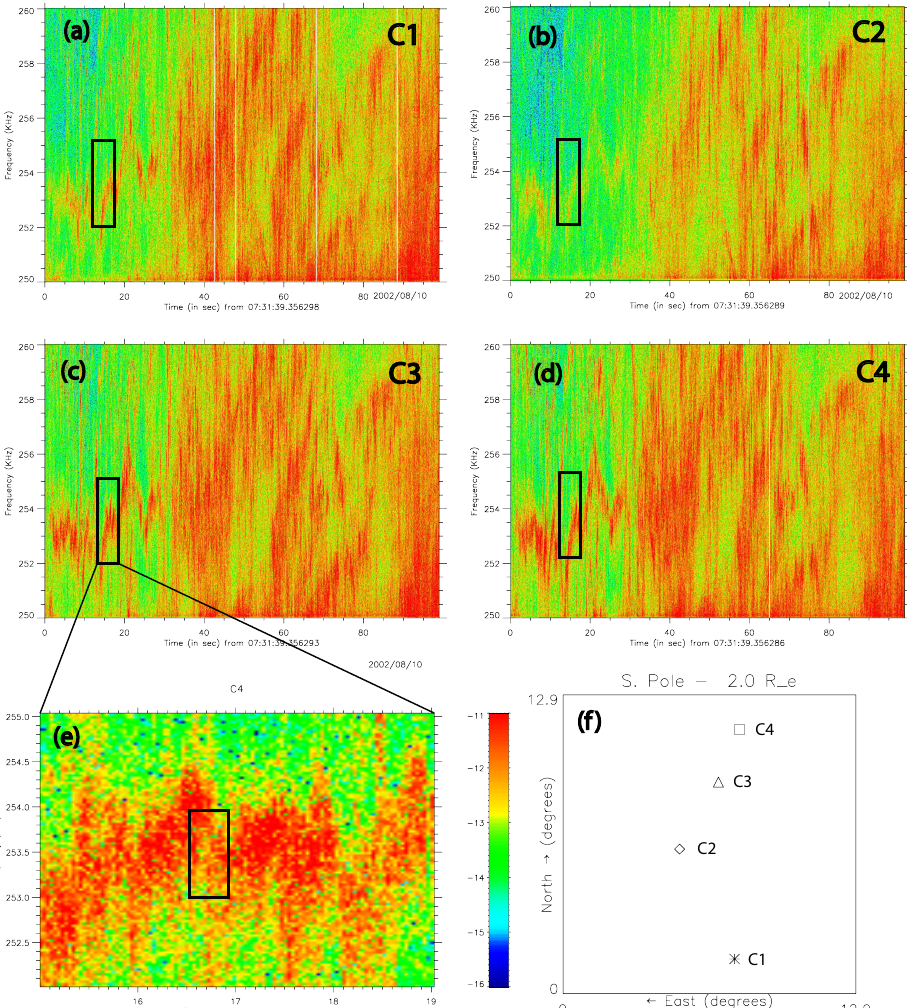
Fig. 2. (a)–(d) Dynamic spectra of AKR emission between 250 and 260kHz received at spacecraft C1, C2, C3, and C4, respectively, on 10 August 2002 from 07:31:39 to 07:33:19 UT. (e) Magnified view of C3 dynamic spectrum (07:31:54.3 to 07:31:58.3 UT and 252 to 255kHz). The black box (0.3s × 1kHz) indicates a typical data window whose Fourier-filtered waveform is used for cross-correlation. (f) Spacecraft configuration (angular coordinates) as seen from the AKR source. The intensity log scale is in units Wm − 2 Hz − 1 . Note that the two (angularly) closely spaced spacecraft C3 and C4 have nearly identical spectra, while those spaced farther apart (C1, C2) have significantly different spectra, indicating that the AKR emission beam has structure on angular scales at least as large as 10 ◦